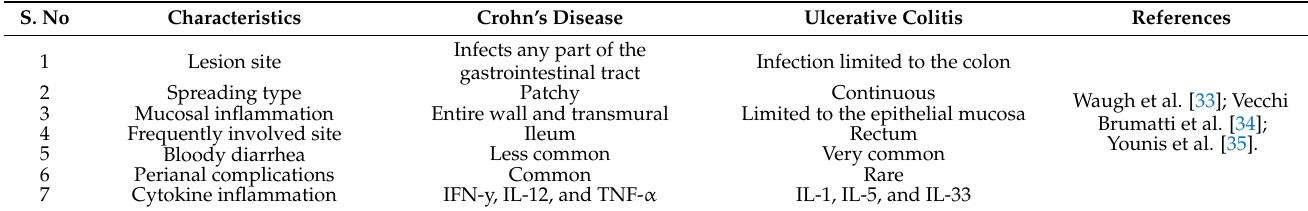
Table 1. The major features of Crohn’s disease and ulcerative